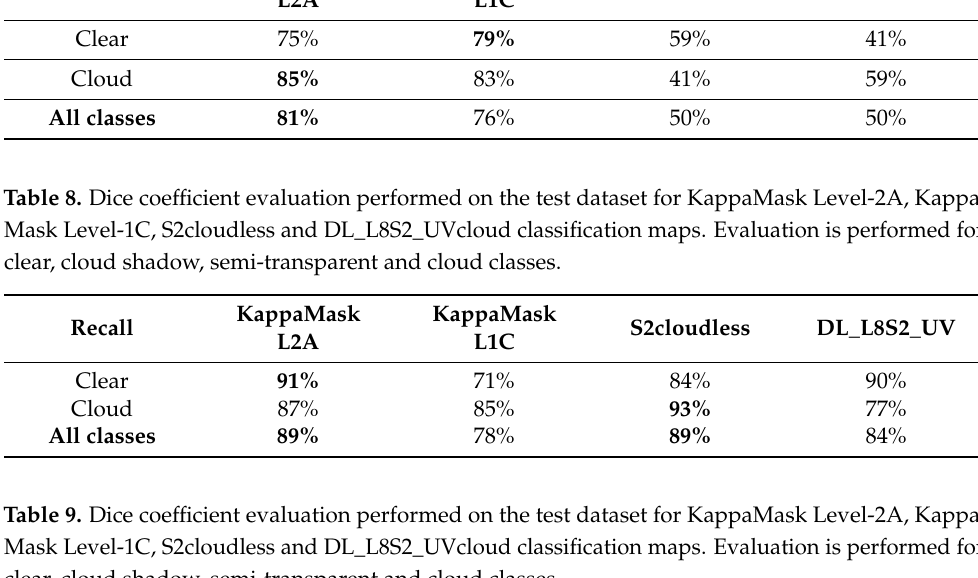
Table 9. Dice coefficient evaluation performed on the test dataset for KappaMask Level-2A,